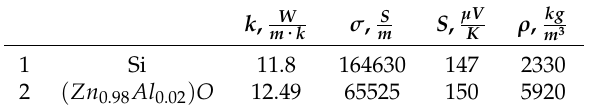
Table 6. Thermoelectric materials used for the evaluation and their properties at 800 ◦ C